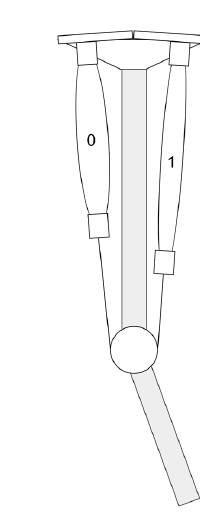
Figure 6. Knee joint control architecture.